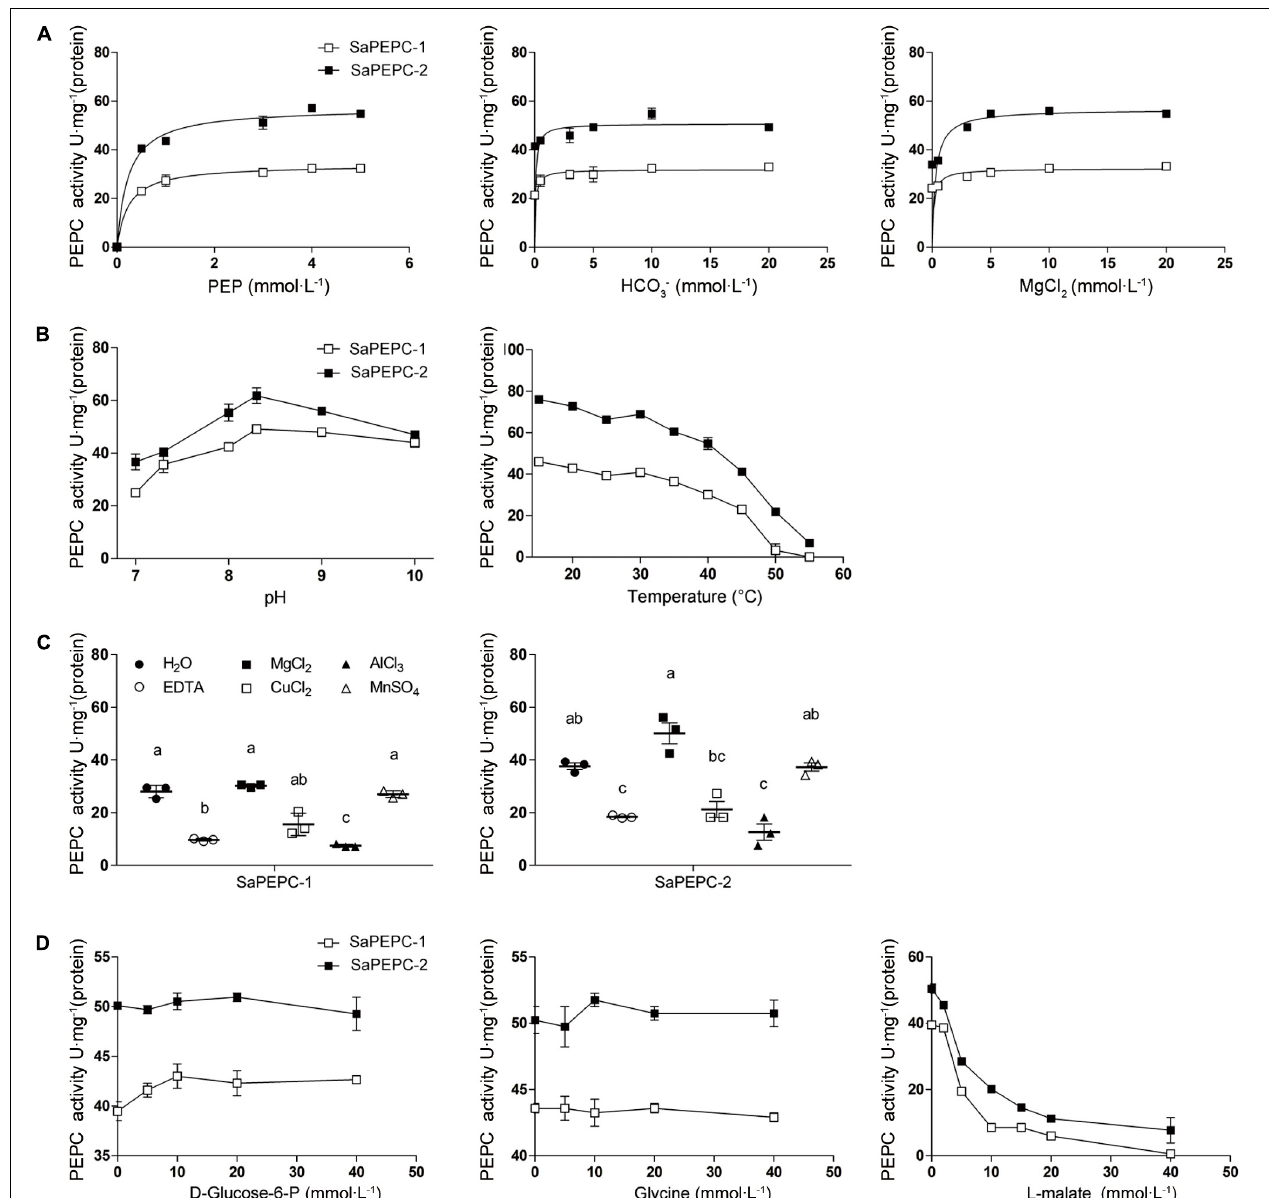
FIGURE 11 | Effects of different factors on enzyme activity of purified recombinant SaPEPC proteins. (A) PEP, HCO 3 - , and MgCl 2 saturation curves; (B) Test of pH and temperature stability; (C) Test of metal ion stability; (D) Test of allosteric activator and inhibitor stability. Different lowercase letters indicate significant difference among different metal ion treatments. Values are means ± SD of three